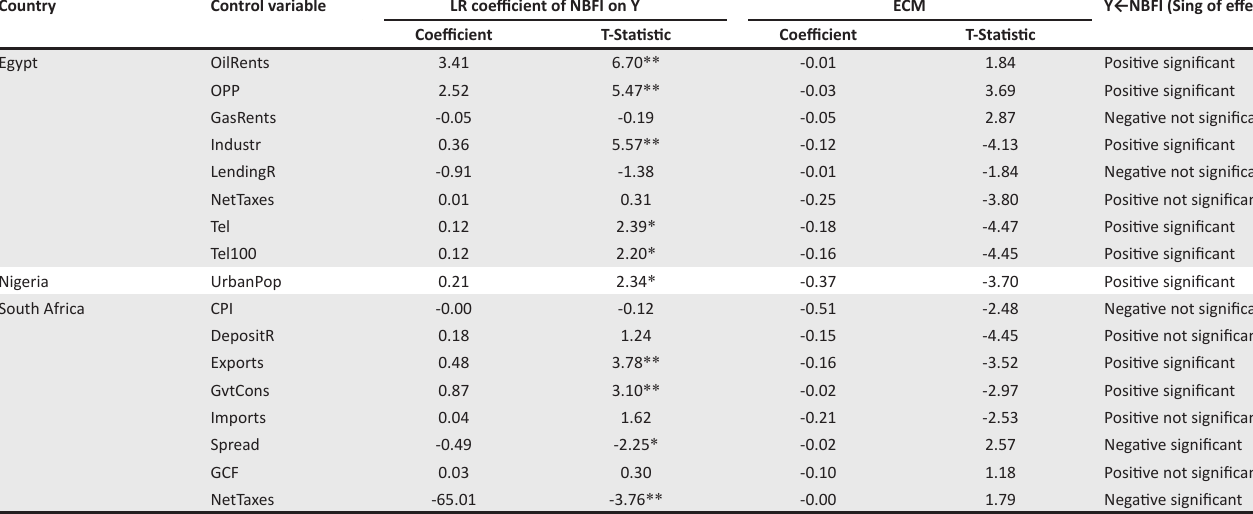
TABLE 4: Long-run parameters of models with causality running from non-bank financial institutions to economic growth.